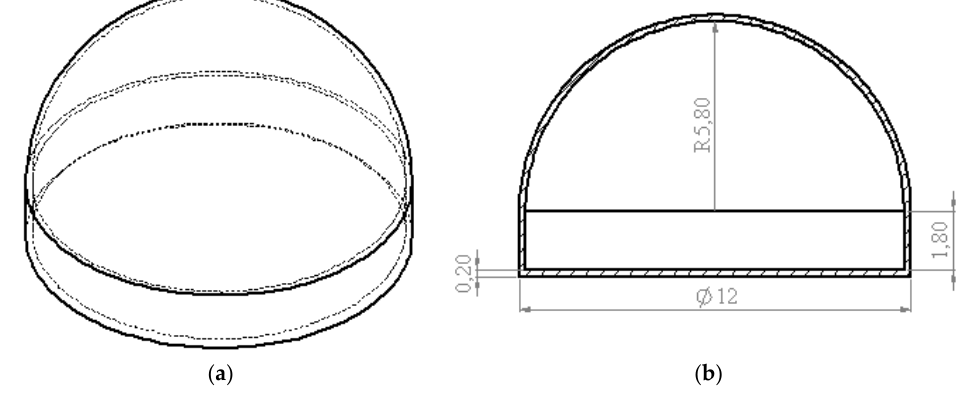
Figure 2. Dimensions of argon reservoir (mm): ( a ) isometric view; ( b ) cross-section view.